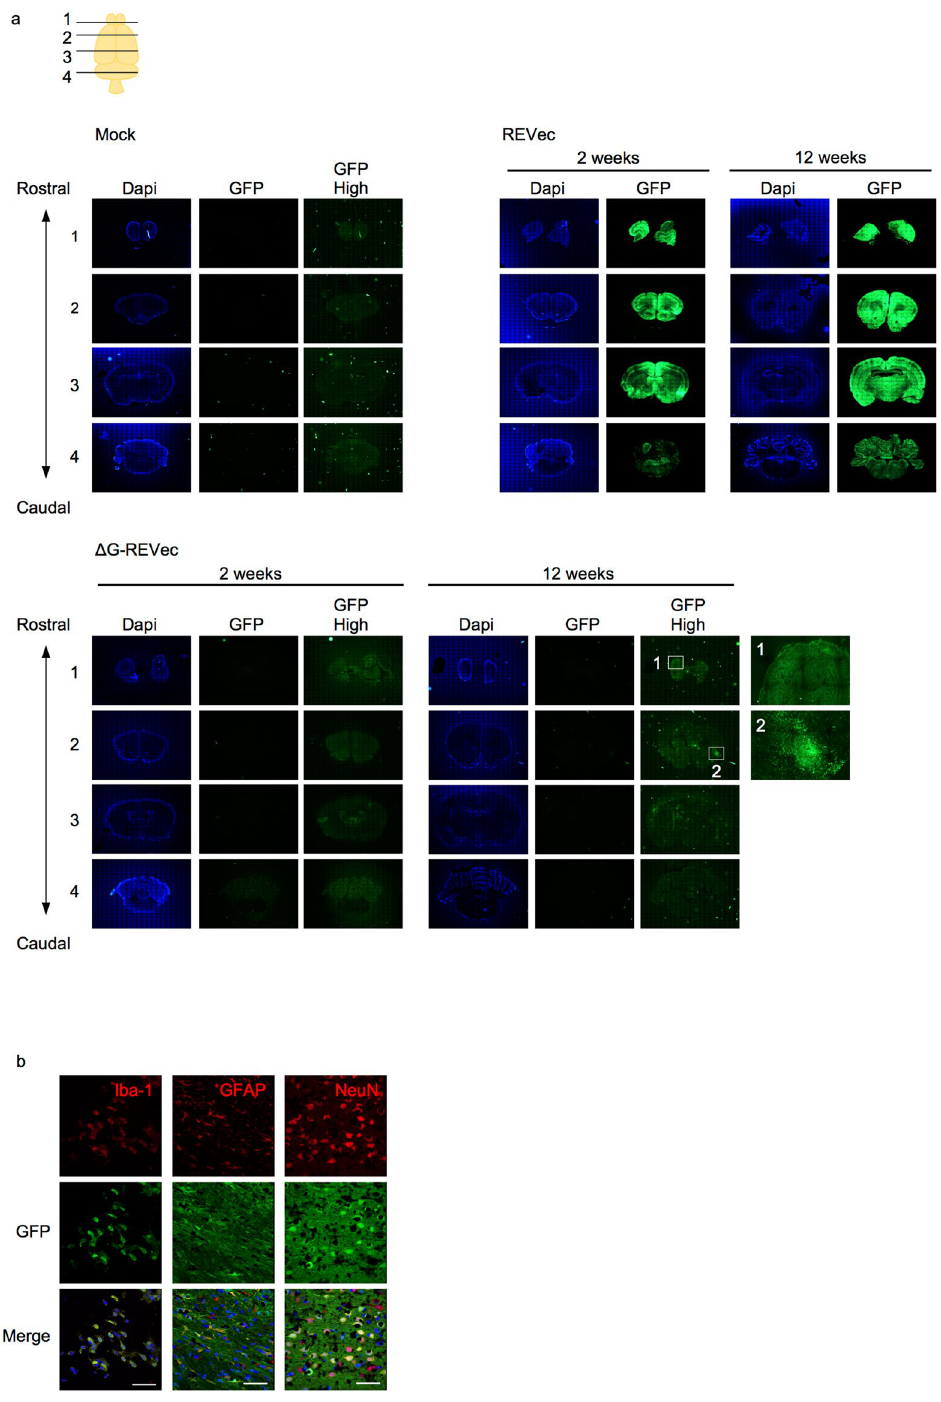
Figure 3. Transgene expression in different brain regions and cell types. ( a ) Immunohistochemical analysis of anterior to posterior coronal brain sections (20 μ m) at 2 and 12 weeks post-injection with 10 4 FFU REVec-GFP or Δ G-REVec-GFP. Higher exposure images of GFP (GFP High) are shown for mock and Δ G-REVec-GFP. Boxes 1 and 2 indicate high magnification images of selected brain regions showing magnified detail of GFP expression. ( b ) Immunohistochemistry of brain sections at 12 weeks after REVec injection co-labeled with GFP (green) and antibodies to microglia (Iba-1), astrocyte (GFAP), and neuron (NeuN). Cell specific markers are labeled in red and counterstained with DAPI. Scale bar, 50 μ